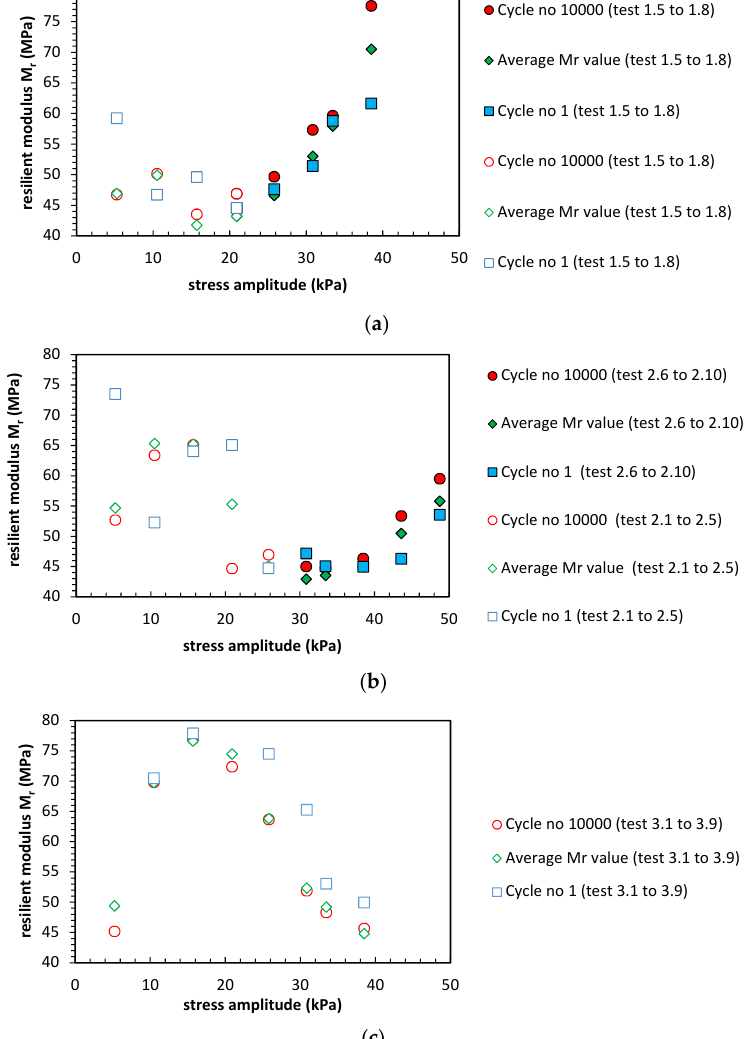
Figure 9. Resilient modulus value of tested sandy clay for first and last cycles, and average value in the radial stress σ ’ 3 equal to ( a ) 45 kPa, ( b ) 90 kPa and ( c ) 135 kPa, as defined in Table 2.